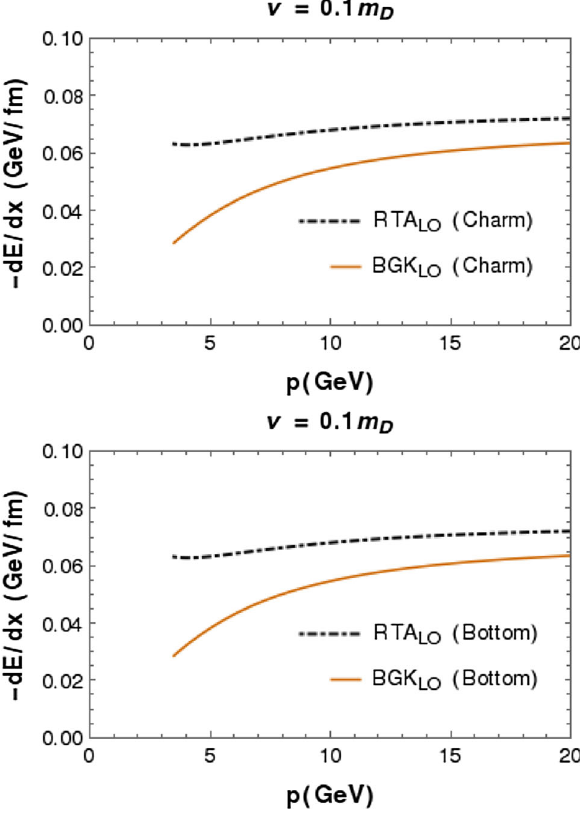
Fig. 5 Comparison of energy loss of the charm and bottom quarks the using BGK and RTA kernels at ν = 0 . 1 m D and T = 2 T c